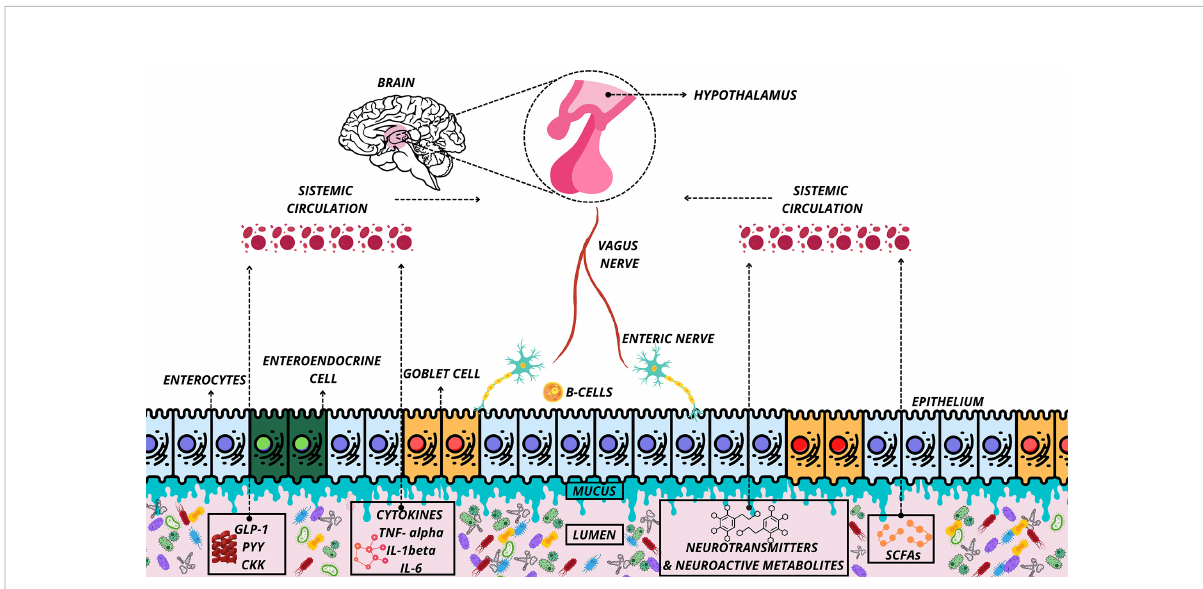
FIGURE 1 Organization of the microbiota-gut-brain axis. Representation of communication of the microbiota-gut-brain axis under normal conditions. Release of neurotransmitters and neuroactive metabolites, cytokines, peptides and SCFAs in the systemic circulation and delivery of these substances to the interacting tissues and hypothalamus. SCFAs, Short-Chain Fatty Acid; PYY, Peptide YY; GLP-1, Glucagon Like Peptide-1; CKK, Cholecystokinin; IL,